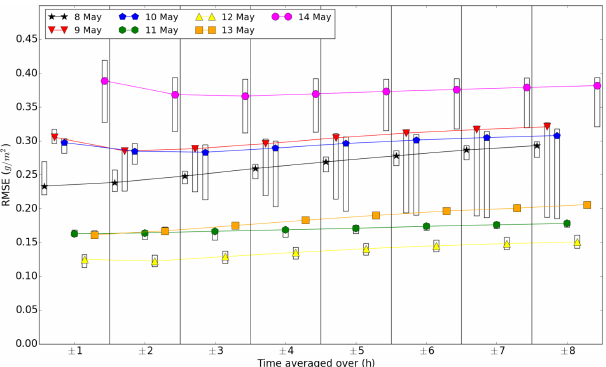
Figure A1. The median RMSE between the SEVIRI observations at t 0 (“truth”) and the truth with 50% of the pixels randomly replaced by the time-averaged observations for each day 8–14 May 2010 (8 May: stars, 9 May: downward-pointing triangles, 10 May: pen- tagons, 11 May: hexagons, 12 May: upward-pointing triangles, 13 May: circles, 14 May: squares). Each random replacement is re- peated 50 times and the error bars show the interquartile range of the RMSE from these